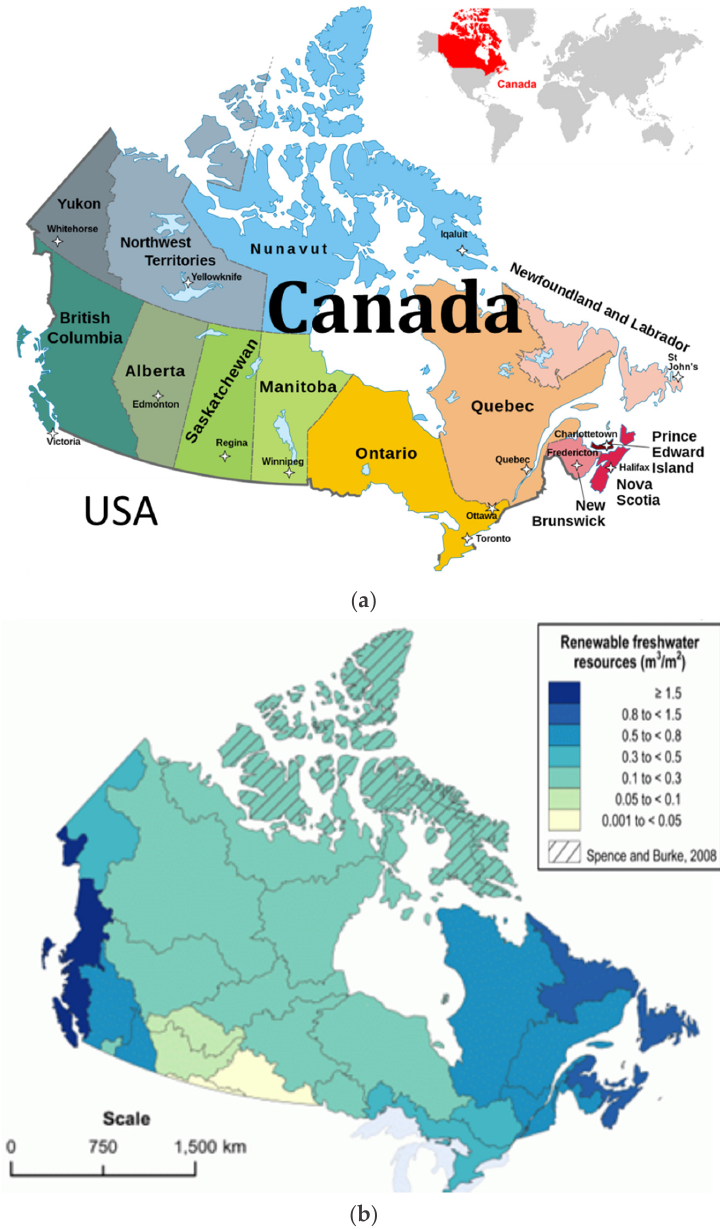
Figure 1. ( a ) The geo-referenced map of Canada showing its location on the globe in North America (the inset) as well as the provincial boundaries and ( b ) spatial distribution of renewable freshwater distribution in Canada